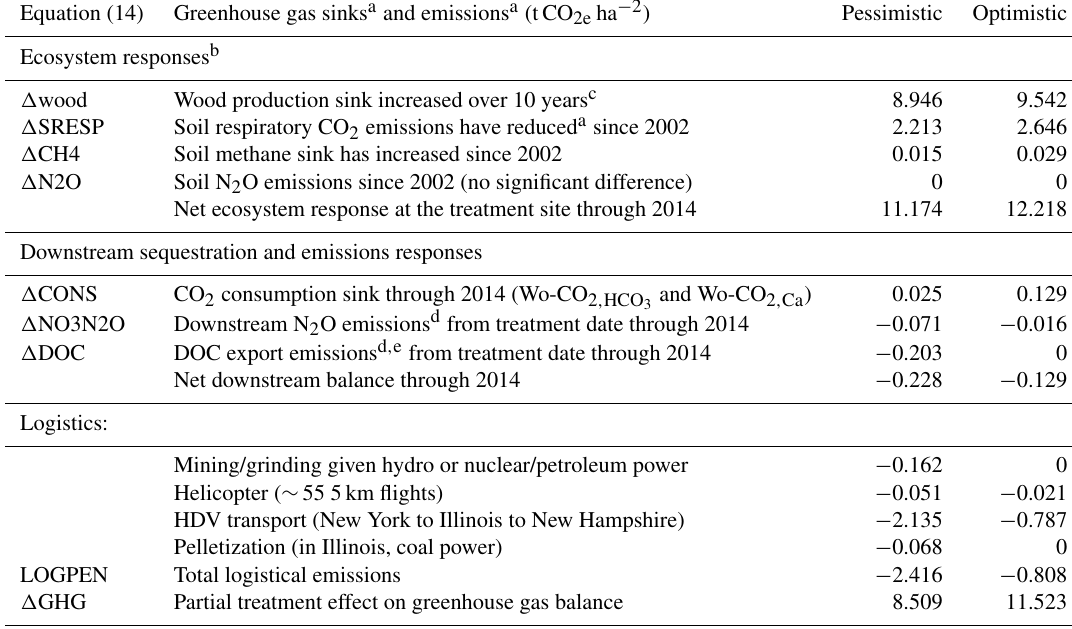
Table 4. Measured elements of the treatment effect on the greenhouse gas budget for the Hubbard Brook Experimental Forest wollastonite